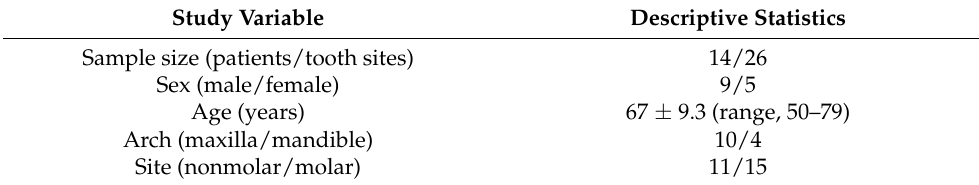
Table 1. Demographic information of participants. Study Variable Descriptive